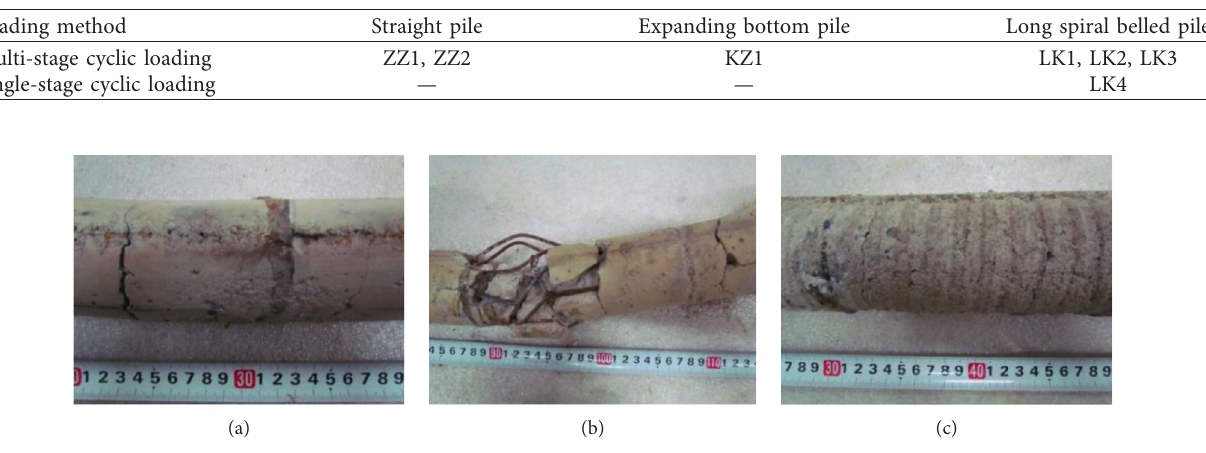
Figure 6: Failure mode of test pile. (a) Straight pile. (b) Expanding bottom pile. (c) Long spiral belled